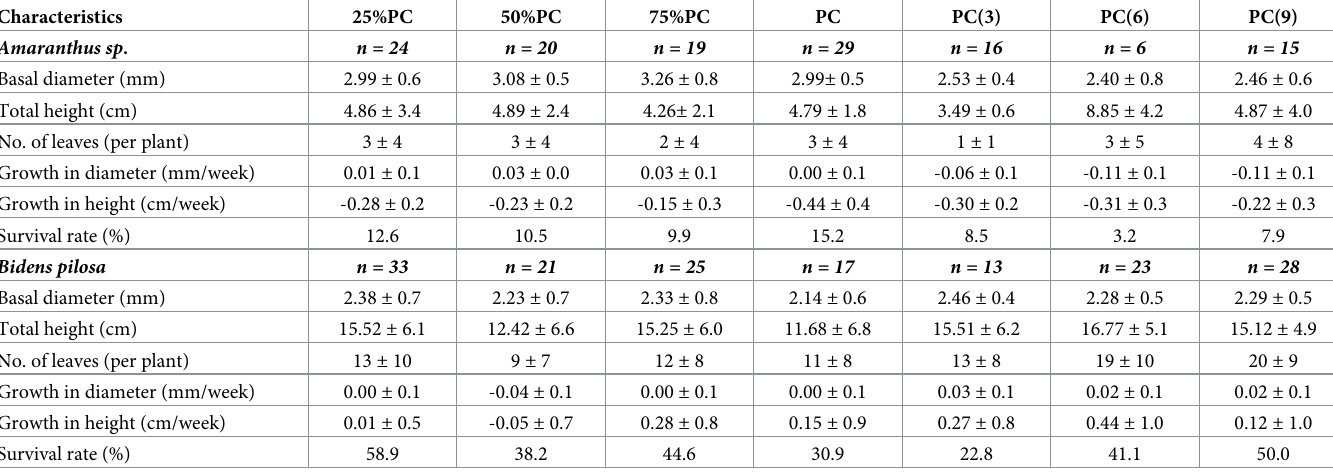
Table 3. Mean values of the considered characteristics ( ± SD) of the study species between water treatments, after second harvest.